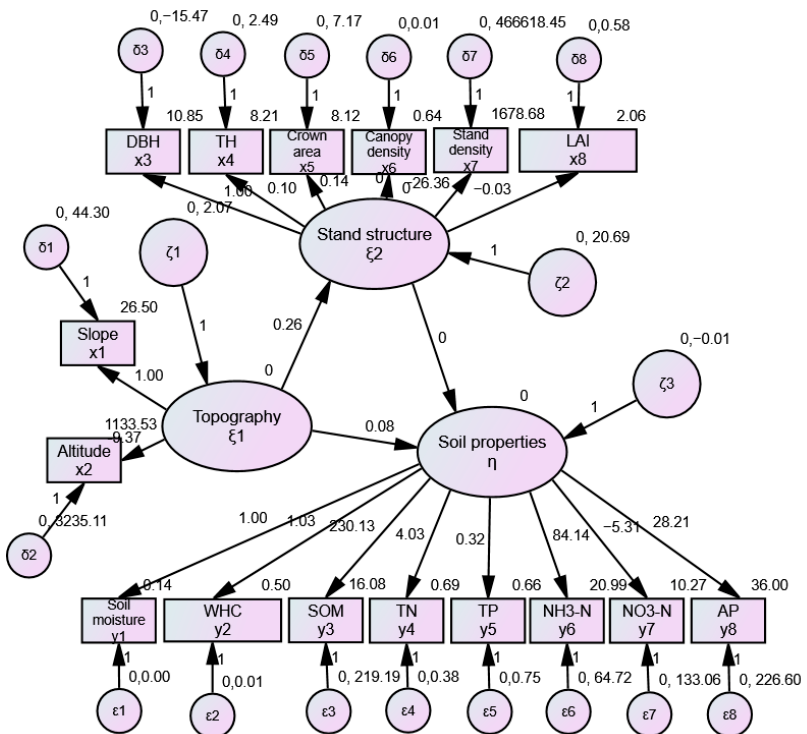
Figure 1. The initial structural equation model (SEM) used in the study. Note: The hypothesized initial model used for predicting topography, stand structure, and soil properties is based on soil and water conservation science. A rectangular box is used for each observed variable, with a measurement error, and the numbers correspond to the standardized path coefficients of the initial model on the single arrows in operation. A value outside of a rectangular box is the mean of the indicator, and a value outside of a round box is the residual error before modification. In the figure, DBH is the abbreviation for diameter at breast height; TH is the acronym for height of tree; LAI is the acronym for leaf area index; WHC is the abbreviation for soil maximum water holding capacity; SOM is the acronym for soil organic matter; TN is the is the acronym for total nitrogen; TP is the acronym for total phosphorus; NH 3 -N is the acronym for ammonia-nitrogen, NO 3 -N is the acronym for nitrate-nitrogen; and AP is the acronym for available